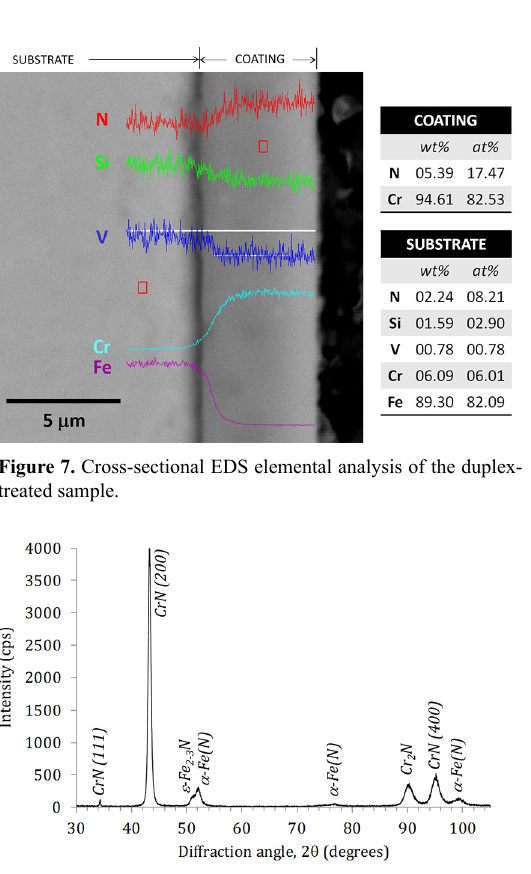
Figure 8. X-ray diffraction patterns of the CrN PVD coating.